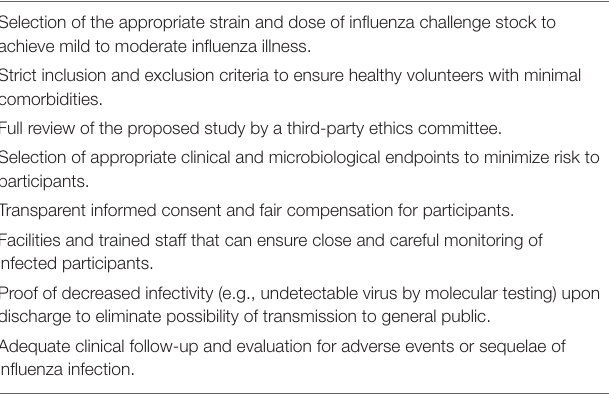
TABLE 1 | Ethical considerations in the design of an influenza challenge model. Selection of the appropriate strain and dose of influenza challenge stock to achieve mild to moderate influenza illness. Strict inclusion and exclusion criteria to ensure healthy volunteers with minimal comorbidities. Full review of the proposed study by a third-party ethics committee. Selection of appropriate clinical and microbiological endpoints to minimize risk to participants. Transparent informed consent and fair compensation for